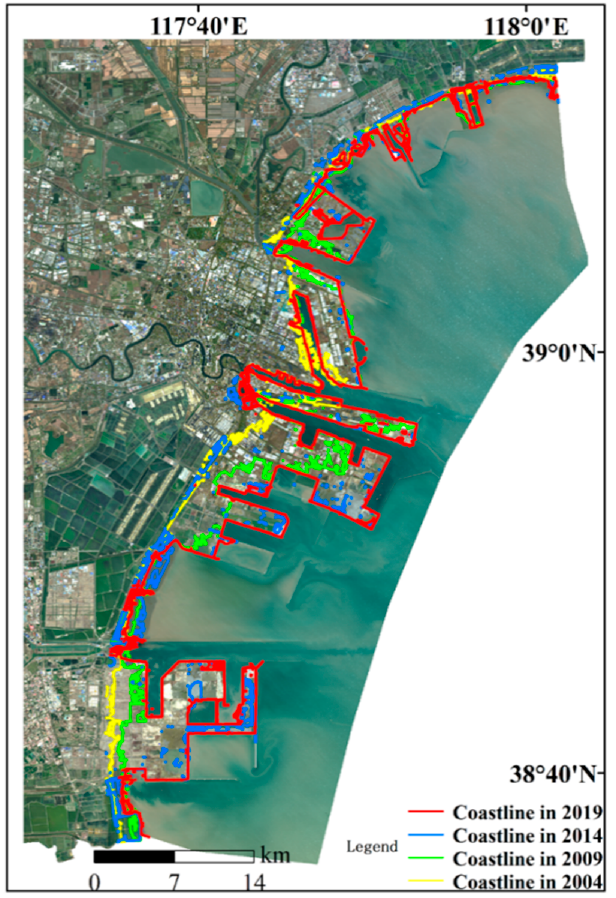
Figure 9. Sea reclamation in Tianjin coastal area for 2004, 2009, 2014 and 2019. The coastal line spatially extended towards the sea.